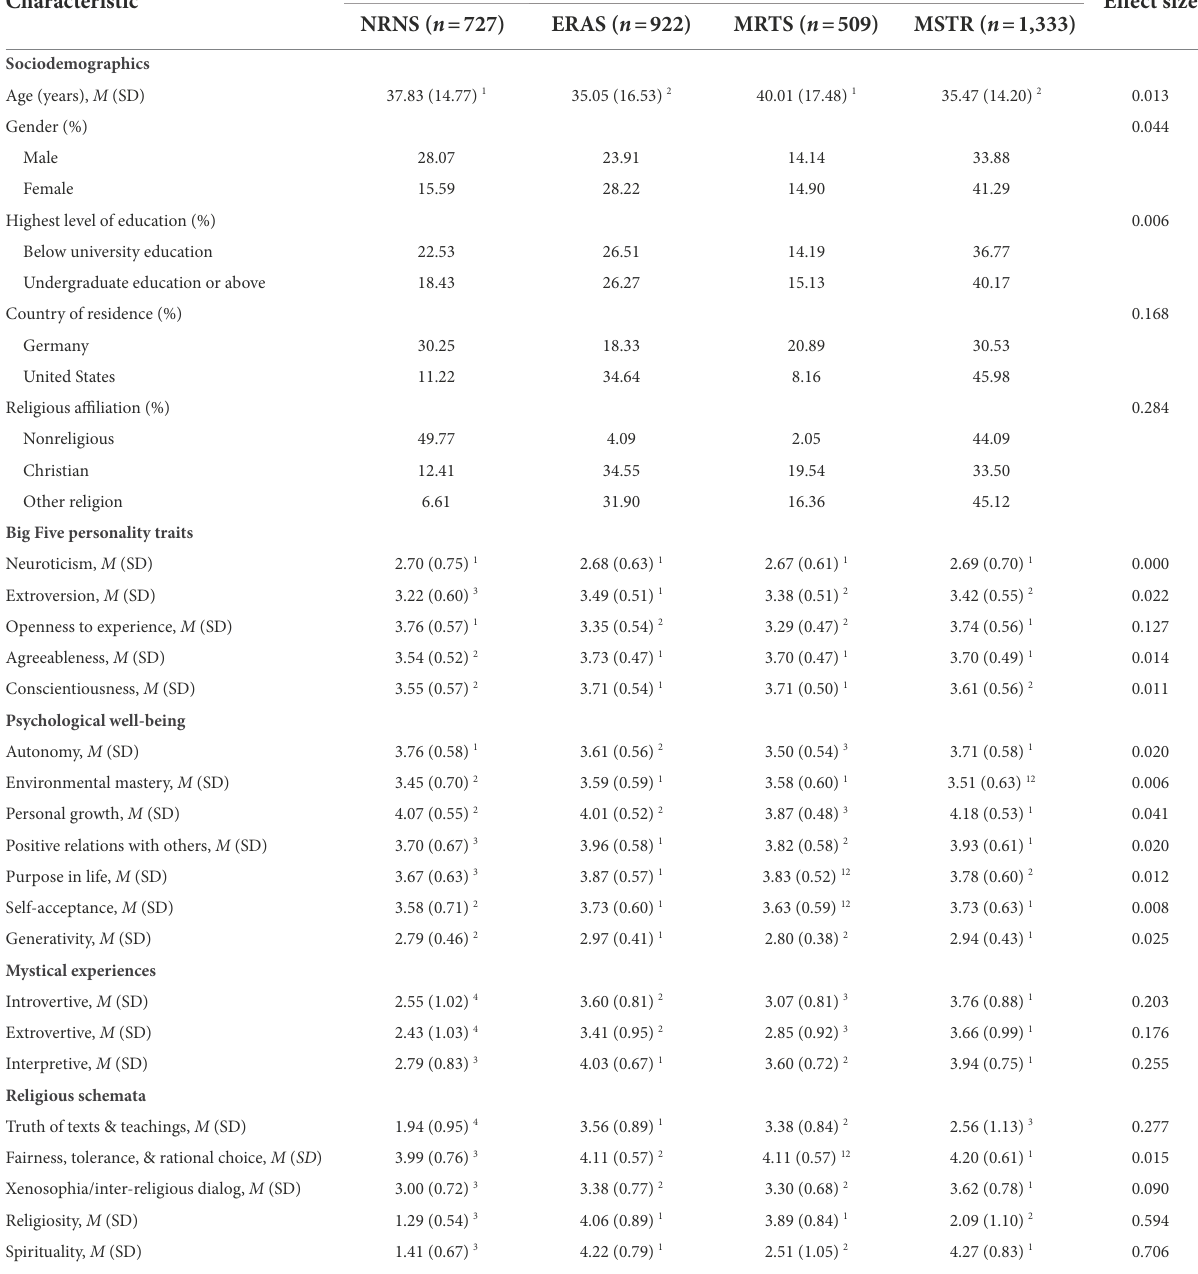
TABLE 1 Distribution of participant characteristics by religious/spiritual identity in Study 1.